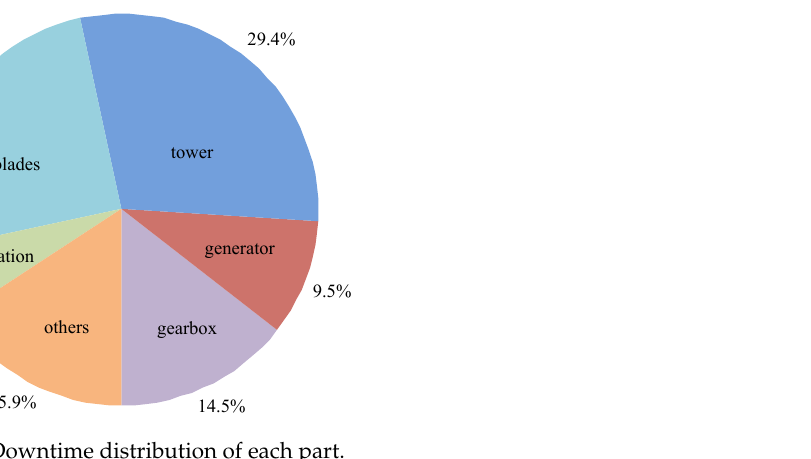
Figure 9. Downtime distribution of each